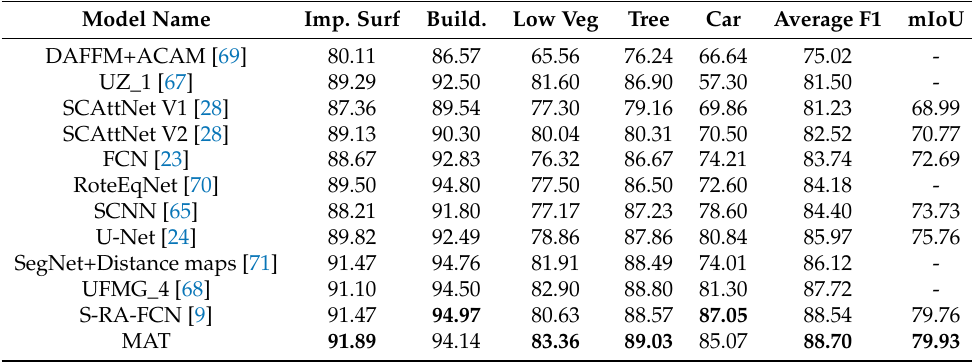
Table 2. Comparison with state-of-the-art methods on the Vaihingen dataset. Bold type indicates the best